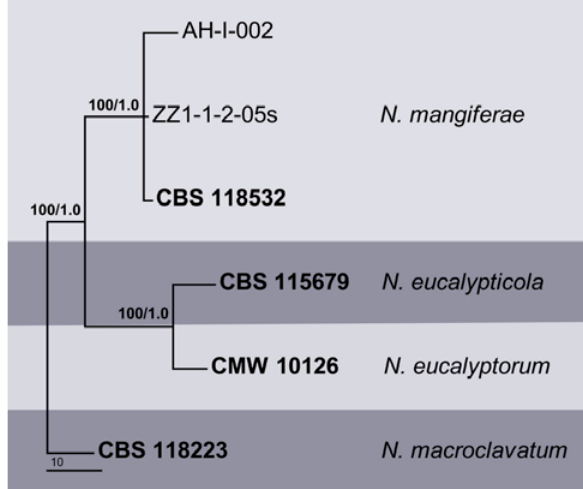
Figure 2. One of the 1000 equally most parsimonious trees obtained from the phylogenetic analysis of the combined dataset of ITS, EF1-α and β-tubulin sequences alignment. The scale bar shows 10 changes. Bootstrap support val- ues for maximum parsimony (MP) greater than 90% and Bayesian posterior probabilities above 0.95 are given above the nodes. Ex-type and ex-epitype isolate numbers are in bold. The tree is rooted to Neofusicoccum macroclava- tum (CBS 118223).